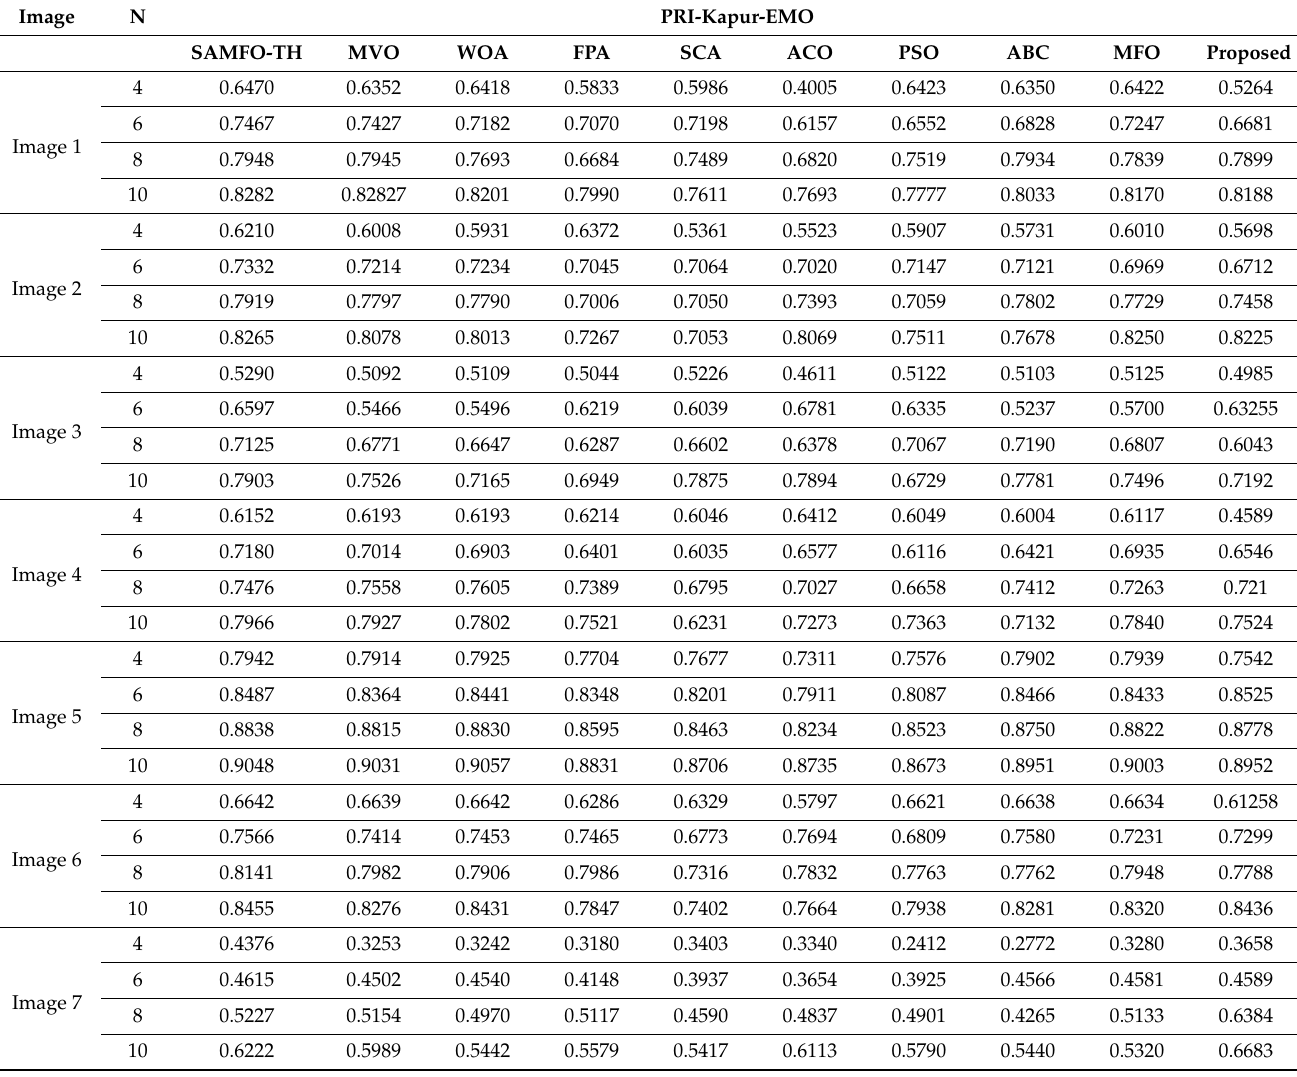
Table 6. Comparison of PRI computed by SAMFO-TH, MVO, WOA, FPA, SCA, ACO, PSO, ABC, and MFO with the proposed model using Kapur’s method with N = 4, 6, 8, and